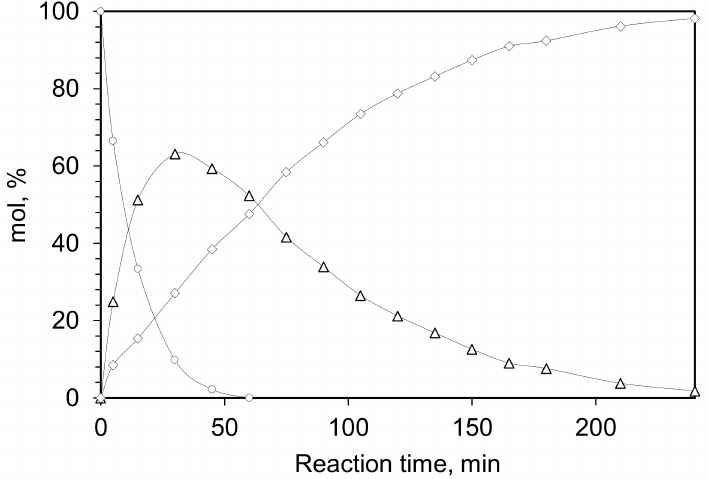
Figure 2. MPS oxidation with H 2 O 2 : molar composition of (o) MPS, ( ∆ ) MPSO and ( ♦ ) MPSO2 vs. reaction time. Reprinted with permission from ref. [46]. Copyright 2018 Springer